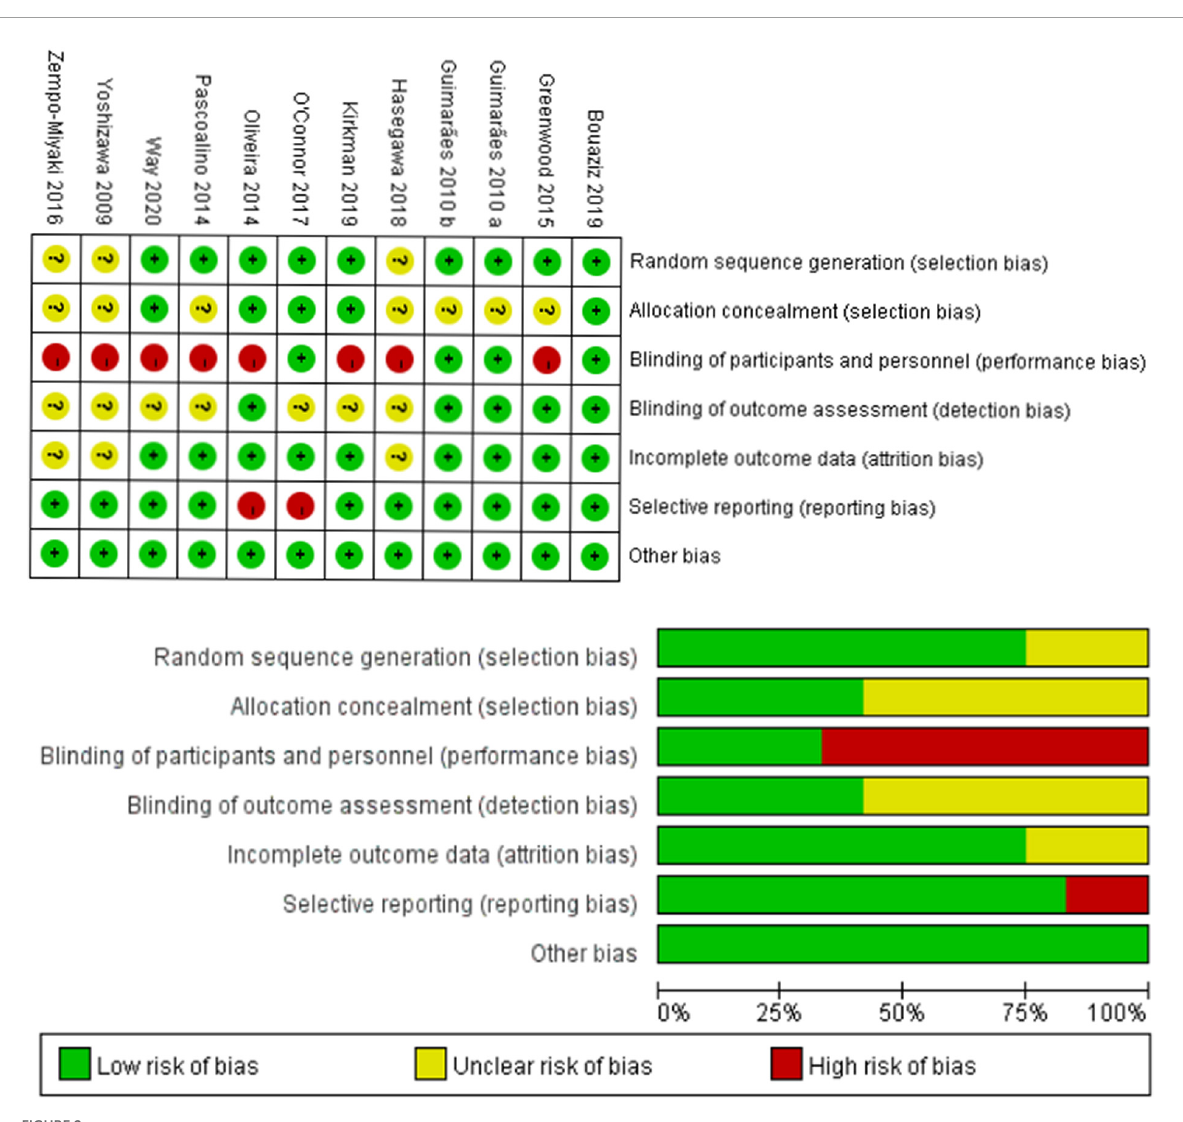
FIGURE2 Results of Cochrane risk of bias